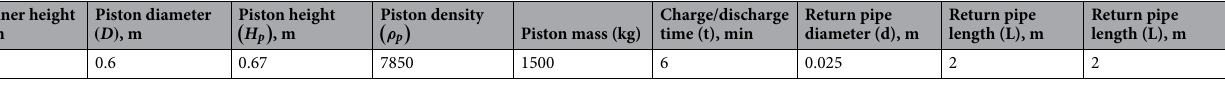
Table 1. Reference data of the physical model.